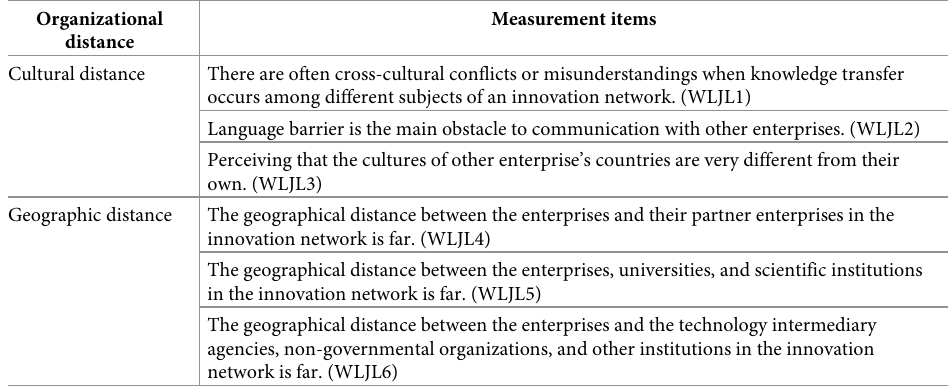
Table 2. Organizational distance measurement